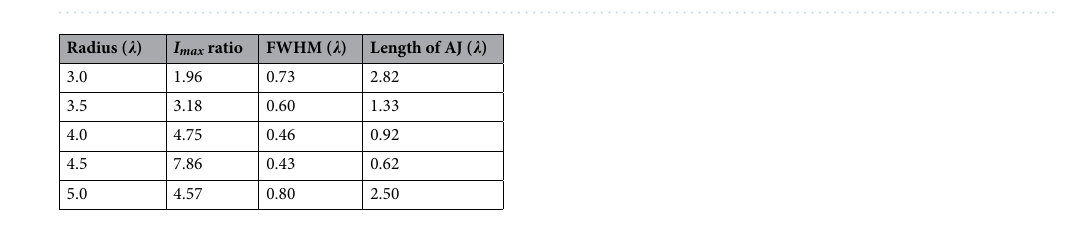
Table 1. Numerical parameter results for different ABS cylinder radii.